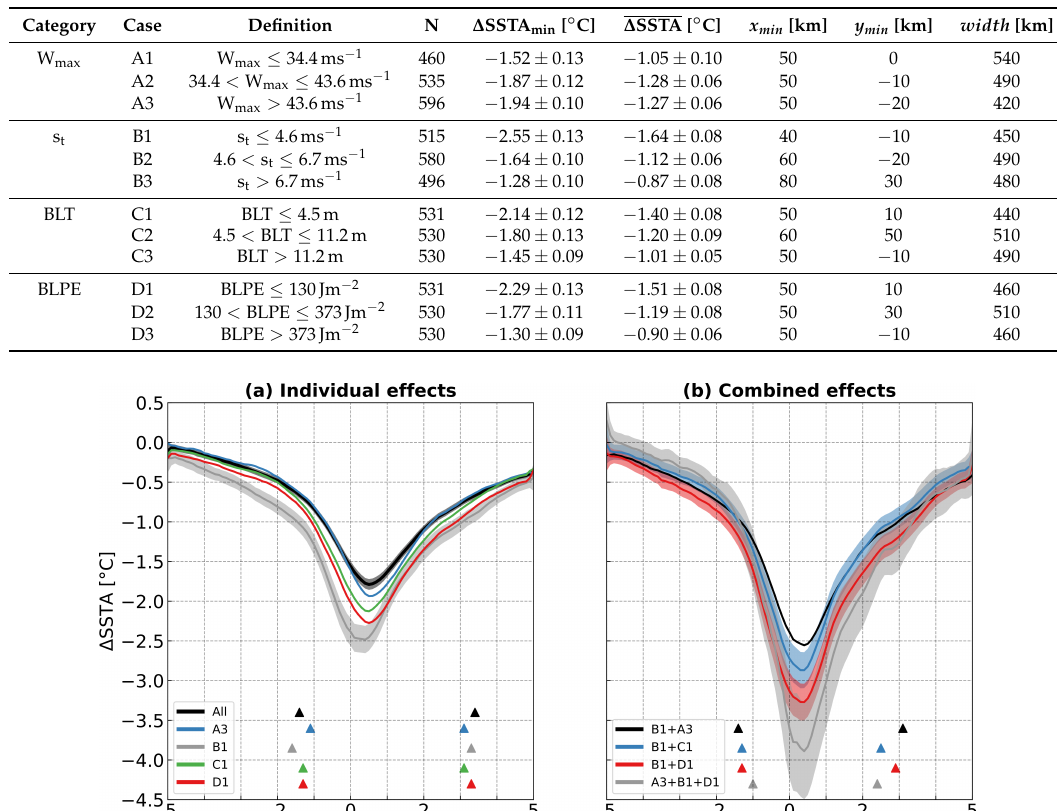
Table 2. Summary of the main cold wake composite results for individual parameters based on the merged SST dataset: 10-min maximum sustained wind speed (W max ), the hurricane translational speed (s t ), barrier layer thickness (BLT) and the barrier layer potential energy (BLPE). See Table 1 for a description of columns. Please note that the total number of observations is lower in comparison to Table 1, the reason is that some observations of BLT and/or BLPE are missing or present negative values (around 200 observations). These observations have not been taken into account in Section 4 and subsequent analysis.